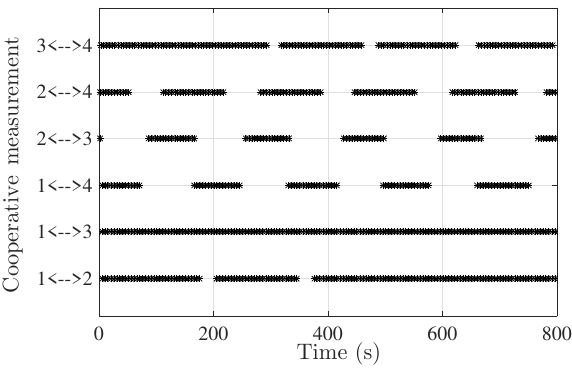
Figure 2. Measurement and communication link availability between two robots with r c = 10.